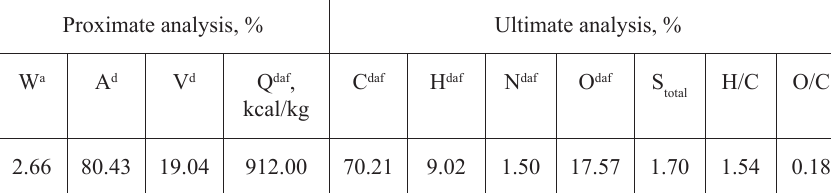
Table 1. Proximate and ultimate analysis of Uvurjargalant oil shale, wt% Proximate analysis, % Ultimate analysis, % W a А d V d Q daf , С daf Н daf N daf O daf S H/C O/C total kcal/kg 2.66 80.43 19.04 912.00 70.21 9.02 1.50 17.57 1.70 1.54